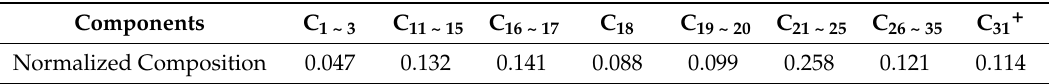
Simulated oil components used in the LH oilfield model (Reprint with